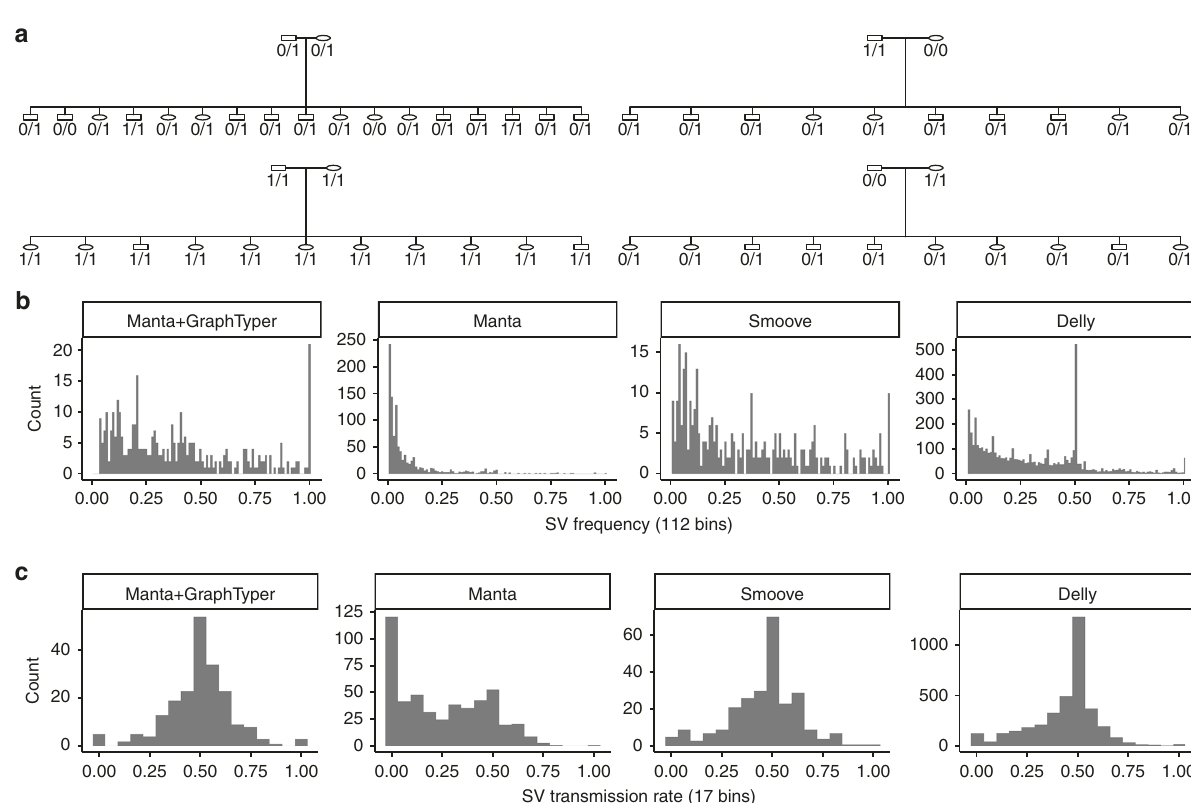
Fig. 3 High-con fi dence SV genotypes in four Icelandic families. a Family tree of the four families. Shown are genotypes of a 313 bp deletion starting at chr20:19,080,772 (GRCh38). b Frequency distribution of SVs called on chromosome 20. There are 112 bins, the number of chromosomes in the callset. c The allele transmission rate of an SV from parent to offspring. For germline variants, the distribution is expected to be symmetric around